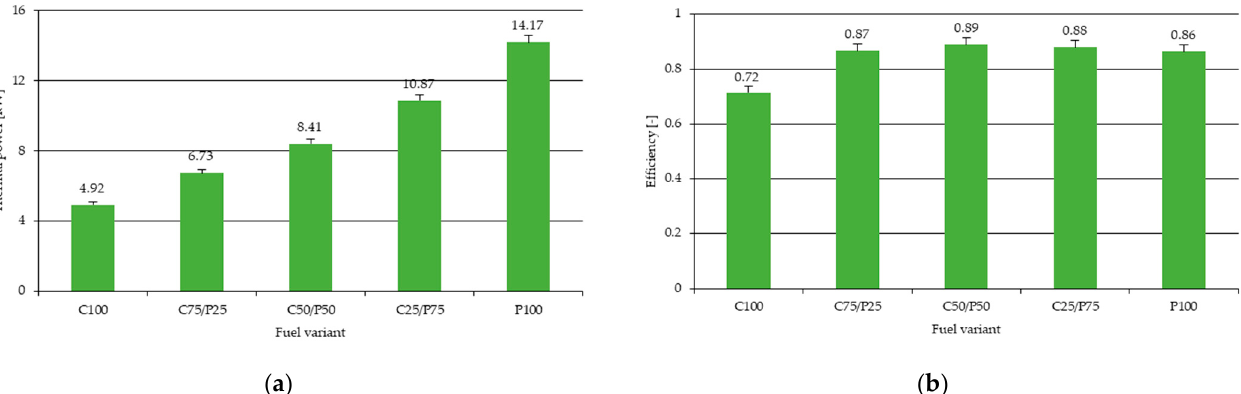
Figure 5. Boiler parameters depending on the fuel: ( a ) Thermal power; ( b ) Efficiency.